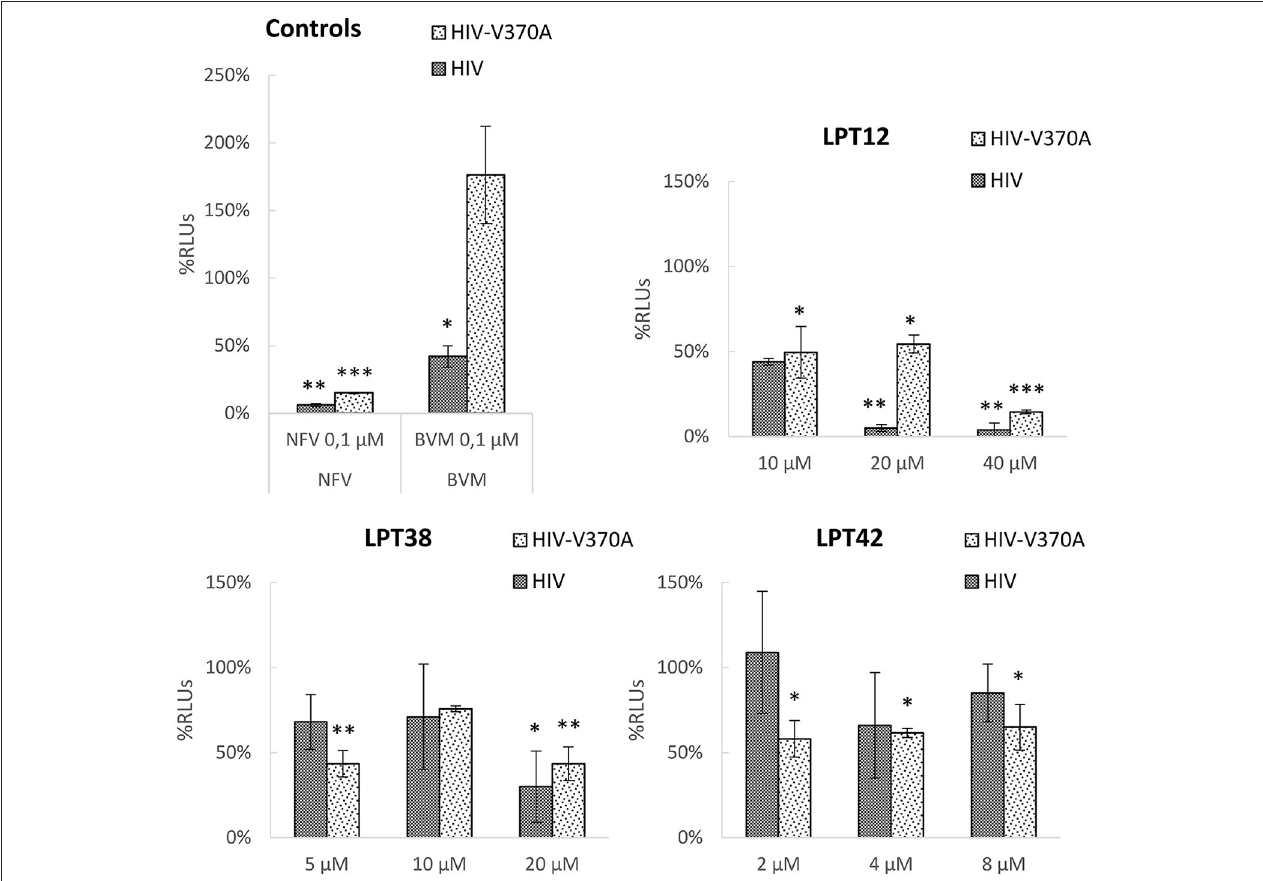
FIGURE 7 | HIV-1 maturation activity of LPTs and bevirimat. 293T cells were transfected with pNL4.3-Luc or pNL4.3-V370A-luc encoding the whole genome of wild type HIV-1 or bevirimat resistant HIV-1 in the presence of different concentrations of LPT12, LPT38, and LPT42 and controls nelfinavir (NFV) and bevirimat (BVM). Supernatants were then collected, p24 Gag protein quantified and used to infect MT-2 cells with the same amount of p24. Results are shown as percentage of RLUs as compared to a non-treated control (100%). ANOVA analysis was performed to determine the value of p (* p < 0.05,** p < 0.01, *** p < 0.001) and NL4.3 (untreated HIV-1 supernatants infection) was used as